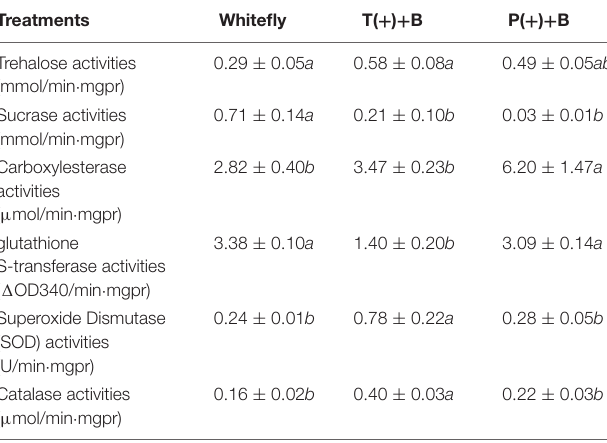
TABLE 2 | The digestive enzymes, detoxification enzymes and protective enzymes in